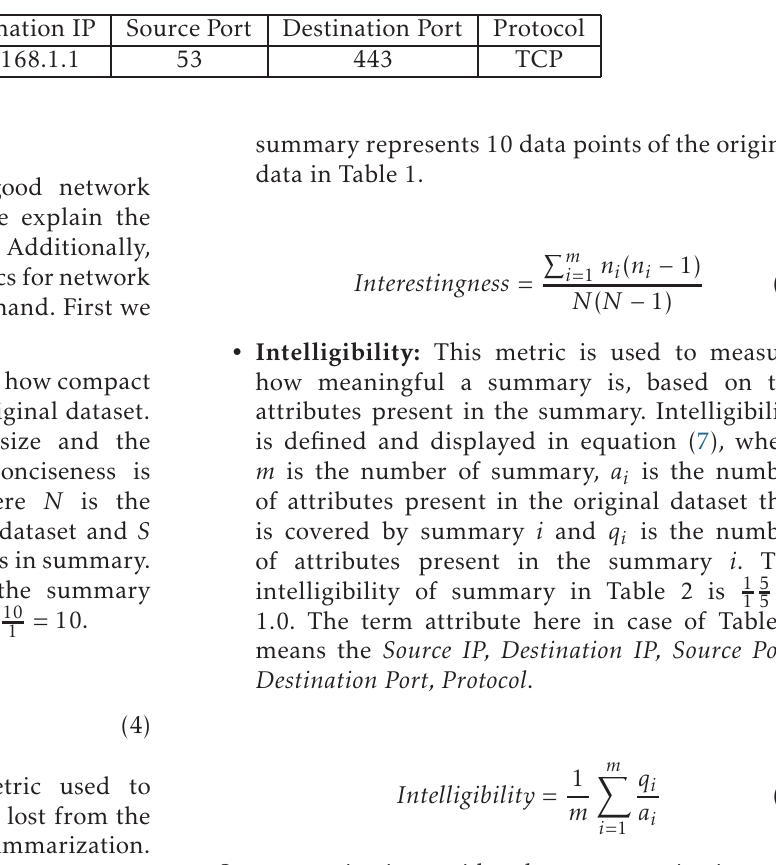
Table 2. A Summary of the dataset in Table 1